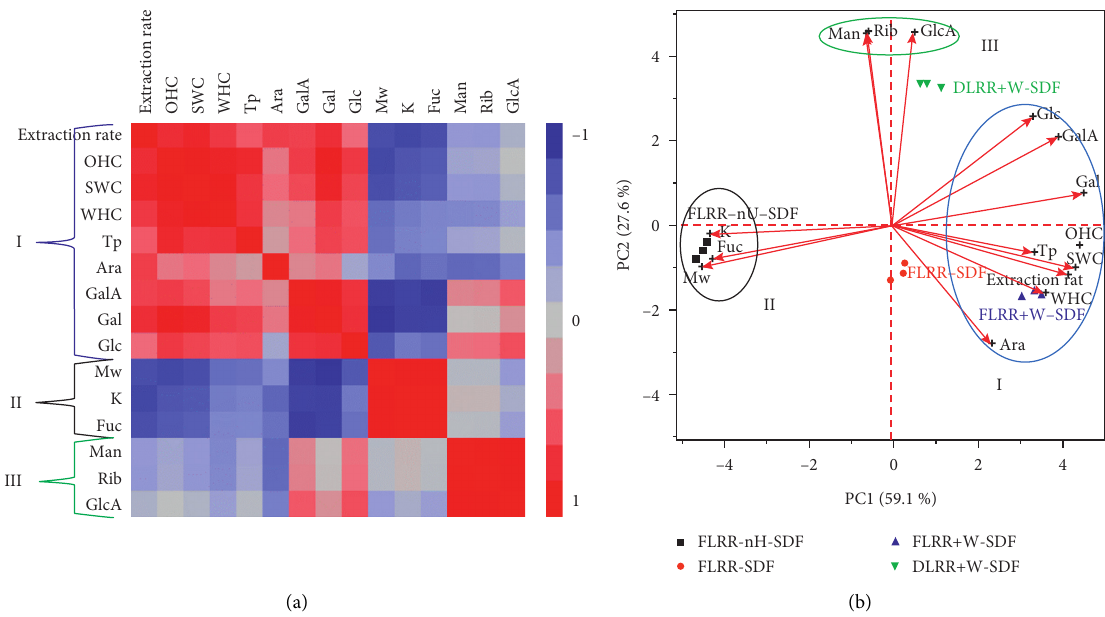
Figure 4: Heat map of the cluster correlation (a) and PCA profile (b) of the indicator data of FLRR-nH-SDF, FLRR-SDF, FLRR +W-SDF, and DLRR+W-SDF from